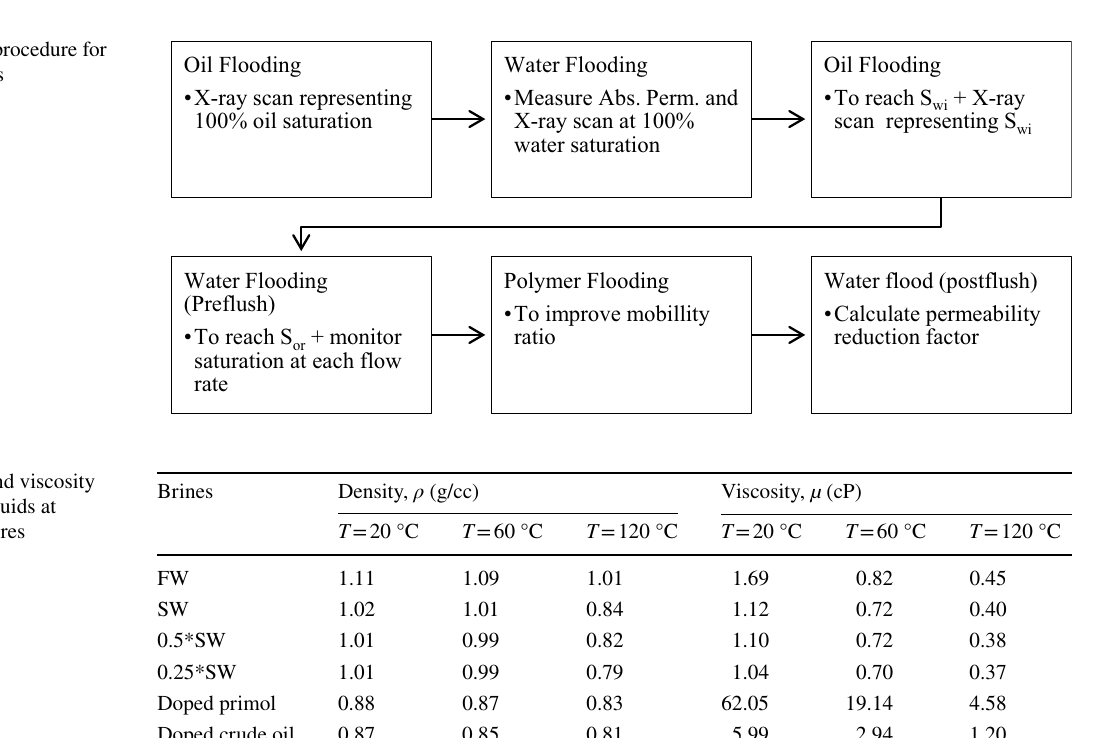
Table 3 Density and viscosity measurements of fluids at different